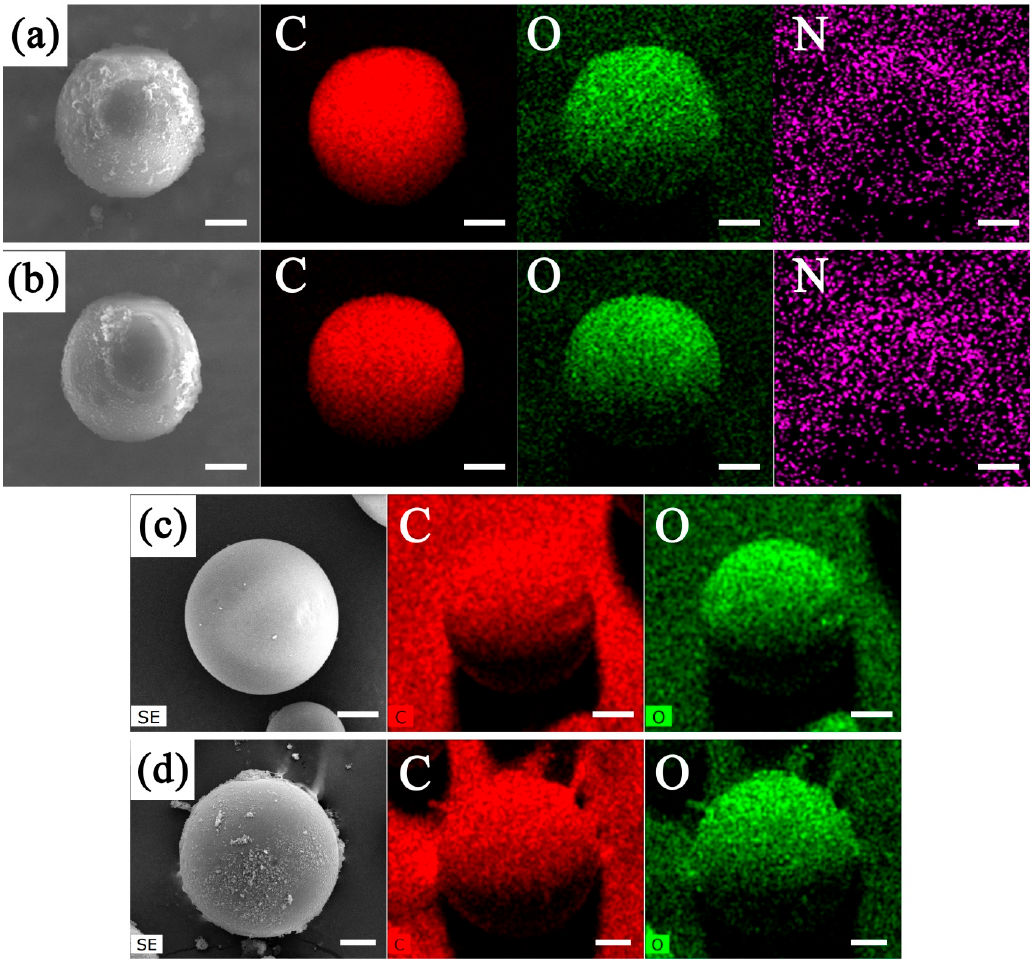
Figure 4. ( a – d ) Elemental mapping images of the intermediate polymer microspheres prepared before the procedure of the etching treatment with HF ( a ), the intermediate polymer microspheres prepared before the procedure of the Soxhlet extraction treatment ( b ), MIPMs ( c ) and non-molecularly imprinted polymer microspheres (NIPMs) ( d ), together with the corresponding SEM images presented on the leftmost side; the scale bars in all of the images are 20 μ m. Functional groups on the MIPMs and NIPMs were then probed by FTIR spectroscopy, and the results are presented in Figure 5a,b. We marked most of the characteristic FTIR absorption peaks and their corresponding functionalities in Figure 5. For the MIPMs, the presence of the carboxyl groups of the poly(methacrylic acid) (PMAA) moiety was most clearly reflected by the FTIR absorption around 3433 and 1728 cm − 1 which were indexed to the stretching vibrations of –OH and –COOH, respectively. The FTIR absorptions revealed the methyl, methylene, and methane in the MIPMs at approximately 2991, 2958, 2930, 1456 and 1391 cm − 1 which were assigned to the stretching and bending vibrations of the C-H group. We also noted the presence of carboxylate functionalities at 1522 and 1477 cm − 1 corresponding to the symmetric and asymmetric stretching vibrations of carboxylate as formed by the partial ionization of carboxyl groups. In comparison between the MIPMs and NIPMs, the apparent difference in the characteristic FTIR absorption was observed due to the stretching vibration of carboxyl groups, as highlighted in Figure 5b. For the MIPMs, this absorption was detected at about 1728 cm − 1 , which was shifted to approximately 1719 cm − 1 as for the NIPMs. Such a kind of redshift has been elucidated to be the enhancement of hydrogen bonding